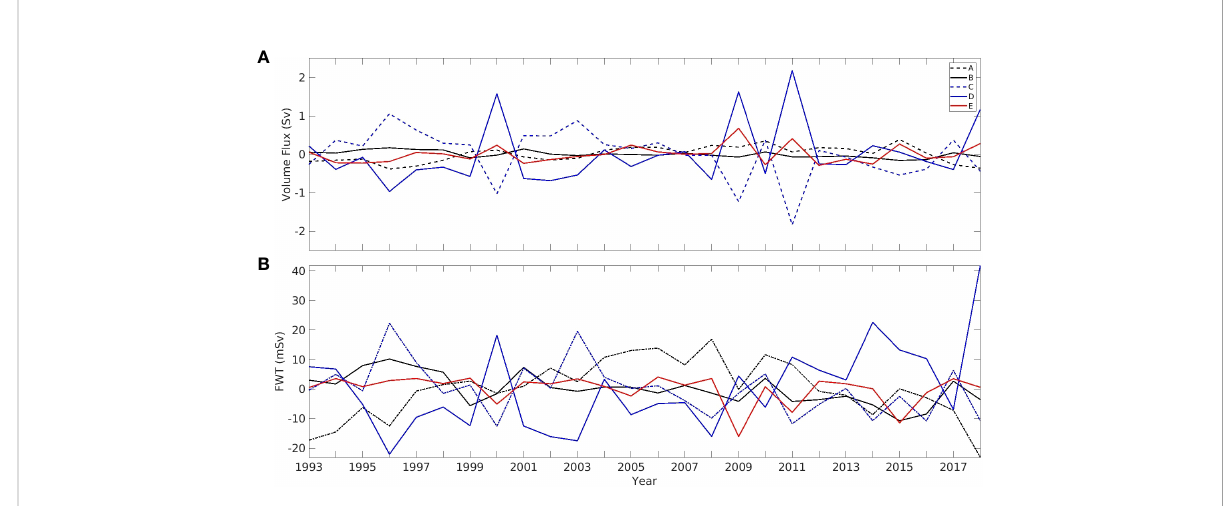
FIGURE 11 As in Figure 9, except for the inter-annual variations of the (A) volume fl ux and (B)